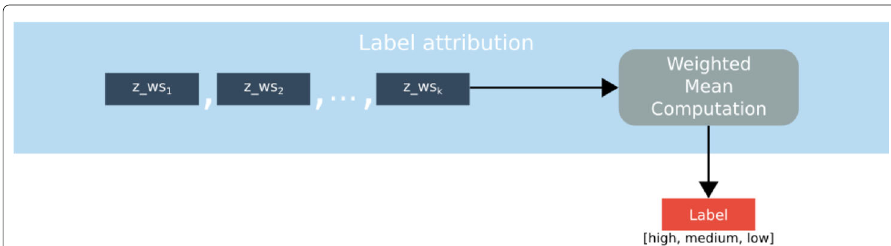
Fig. 9 Label attribution process. A weighted mean combining the similarity score computed from various window size is used to compute the final label of the tested